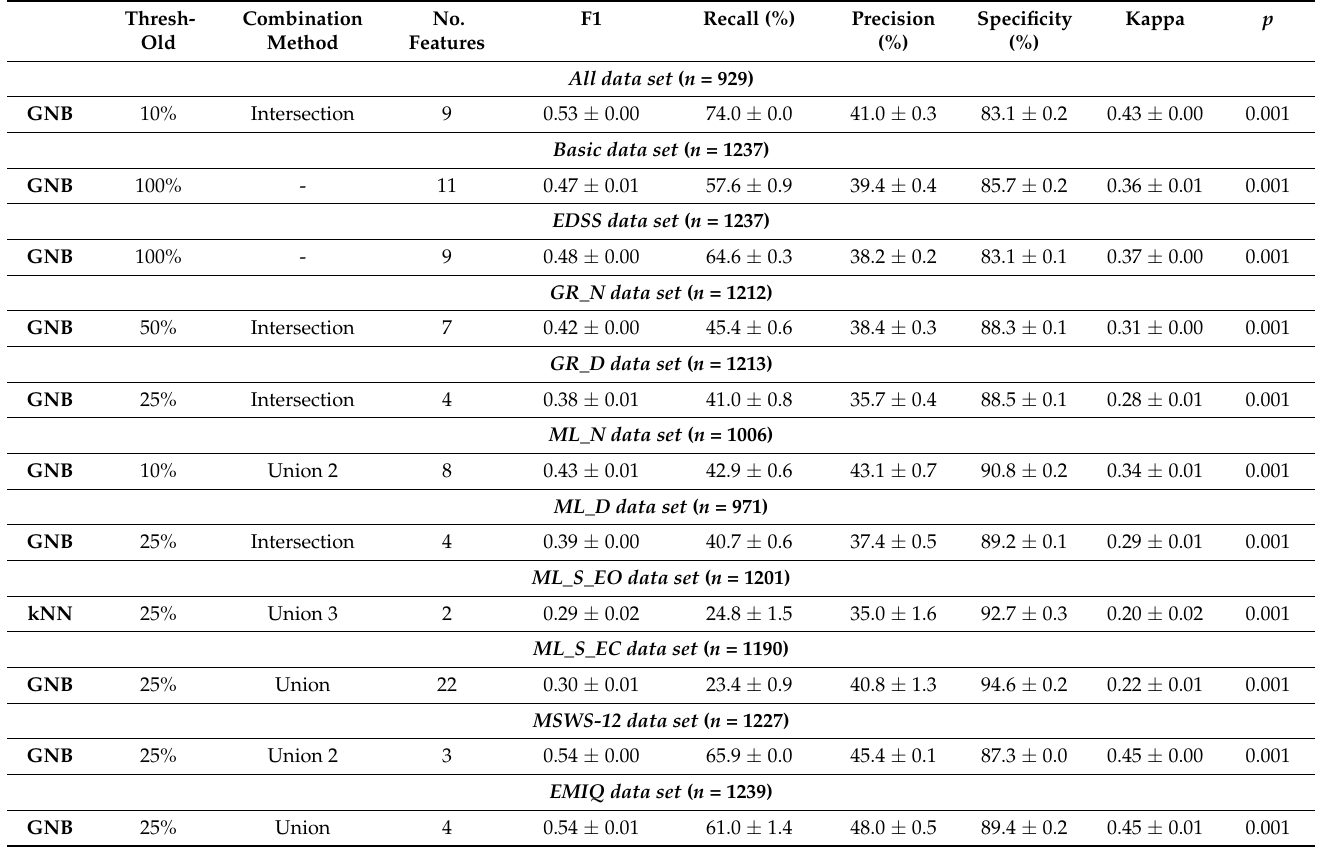
Table 4. Performances of the best classification model per data set on detecting falls. The values are presented as mean ± standard deviation across 5-fold cross-validation repetition. p -value via permutation